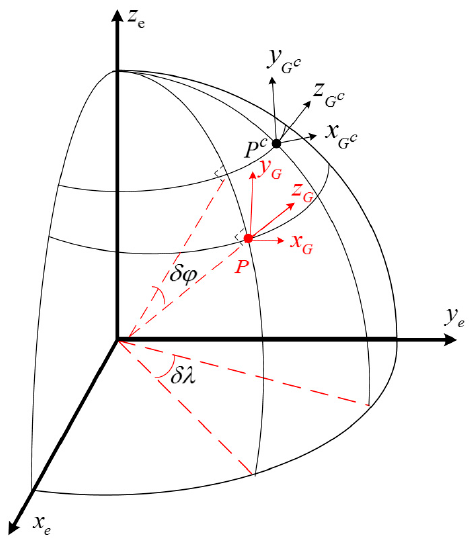
Figure 4. Relationship between G and G c frames.